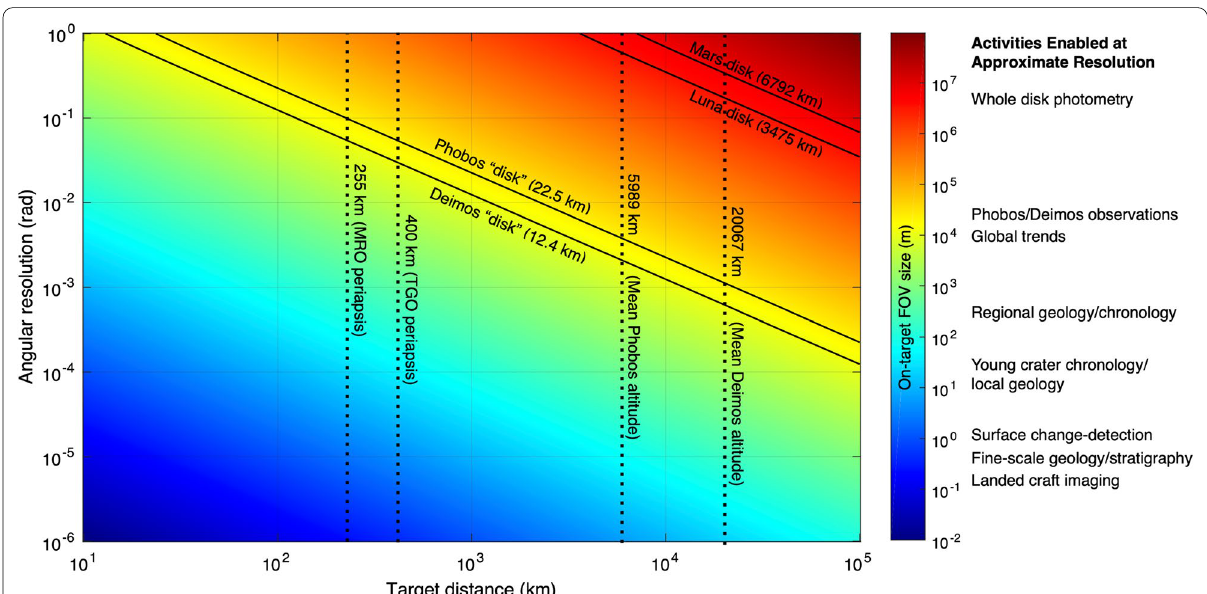
Fig. 2 Assessment of science potential for imaging instruments. On‑target field of view (FOV) size in metres as a function of distance to the target being observed and angular resolution of the observing